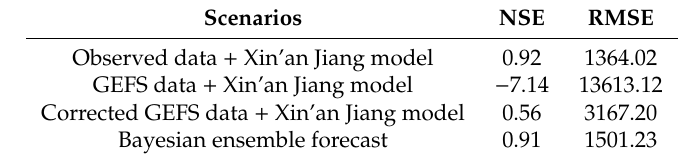
Table 7. NSE and RMSE of the four scenarios.